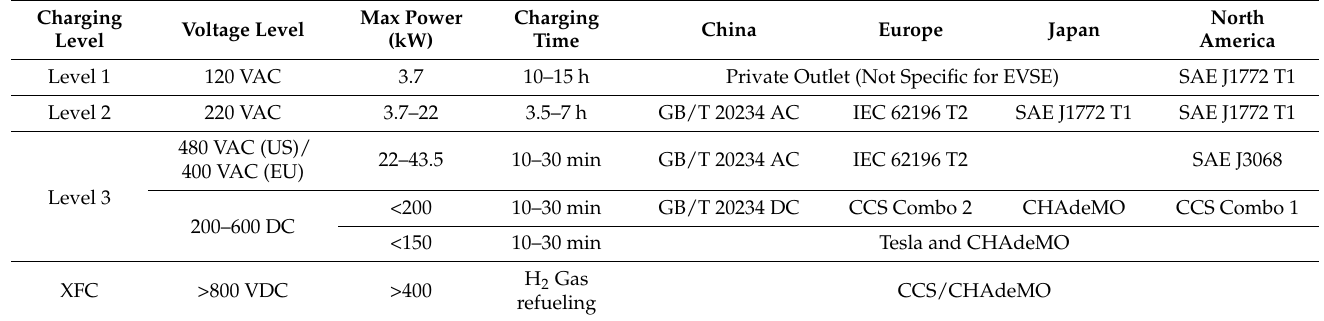
Table 2. Charging power level standards and configurations adapted from